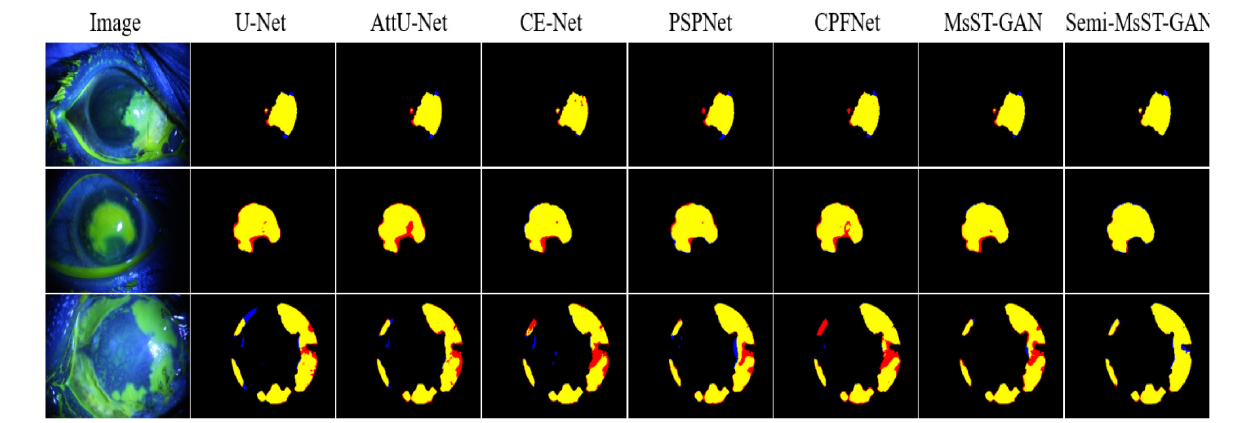
FIGURE 4 | Examples of corneal ulcer segmentation. From left to right : original image, U-Net, Attention U-Net, CE-Net, PSPNet, CPFNet, MsST-GAN, and the proposed method. Yellow represents the correctly segmented region, while red and blue are the results of false-positive segmentation and false-negative segmentation,